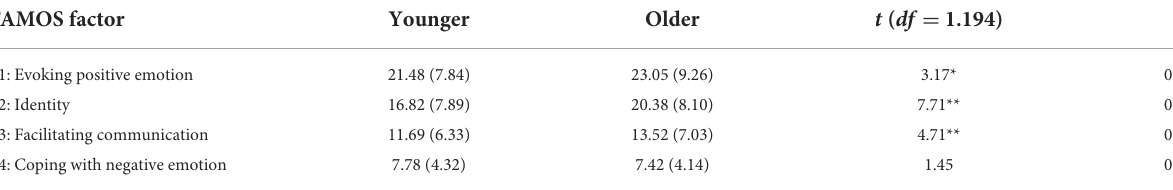
TABLE 3 Means and t -test results for each the FAMOS factor in each group. FAMOS factor